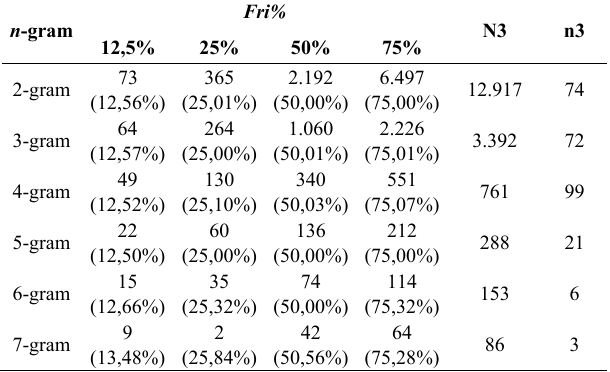
Table 1. N3 and n3 of the different n -grams from HCII.